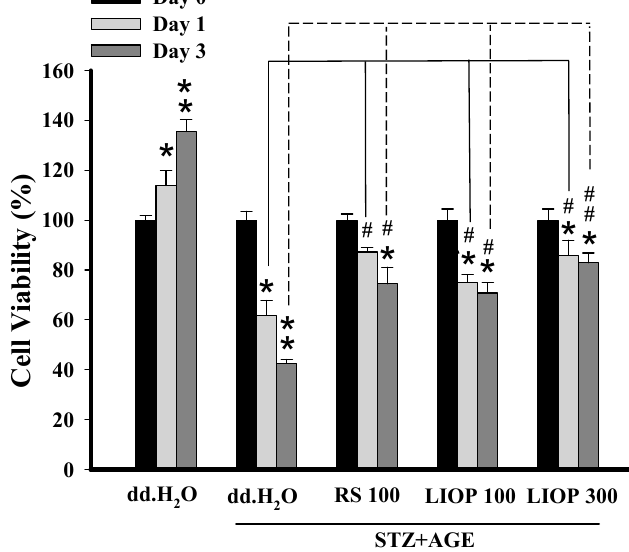
Figure 7. The protection from STZ + AGEs-induced cell toxicity. The renal tubular epithelial cells (LLC-PK1) in vitro were treated with STZ (8 mM) + AGEs (3 mg/mL) causing cell gluctotoxicity at 24 and 72 h. Co-treatment of LIOP (100 and 300 μ g/mL) and RS (100 μ g/mL), the protective effects from cytotoxicity were determined by MTT. Each value represents the mean ± SE of three replicate experiments, and the results are expressed as population growth (control as 100%). *: p < 0.05, **: p < 0.01 significantly different from at day 0 in same treated group. #: p < 0.05, ##: p < 0.01 significantly different from dd.H 2 O group at day 1 or day 3. dd.H 2 O: vehicle control; RS: rosiglitazone; LIOP: